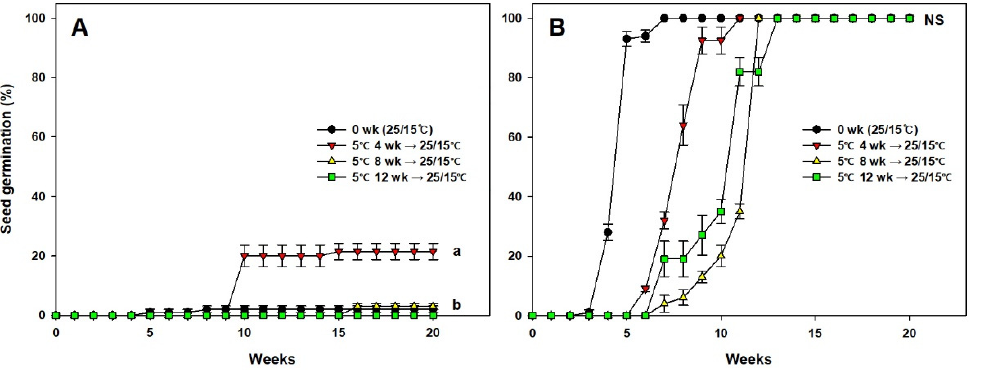
Figure 5. Germination of Hovenia dulcis seeds by cold stratification treatments after ( A ) no scarification and ( B ) 98% sulfuric acid scarification for 1 h. Vertical bars show ± SE of four replicates. The different letters represent statistically significant differences for germination percentages according to treatments in the 20th week as determined by Duncan’s multiple range test ( p < 0.05).